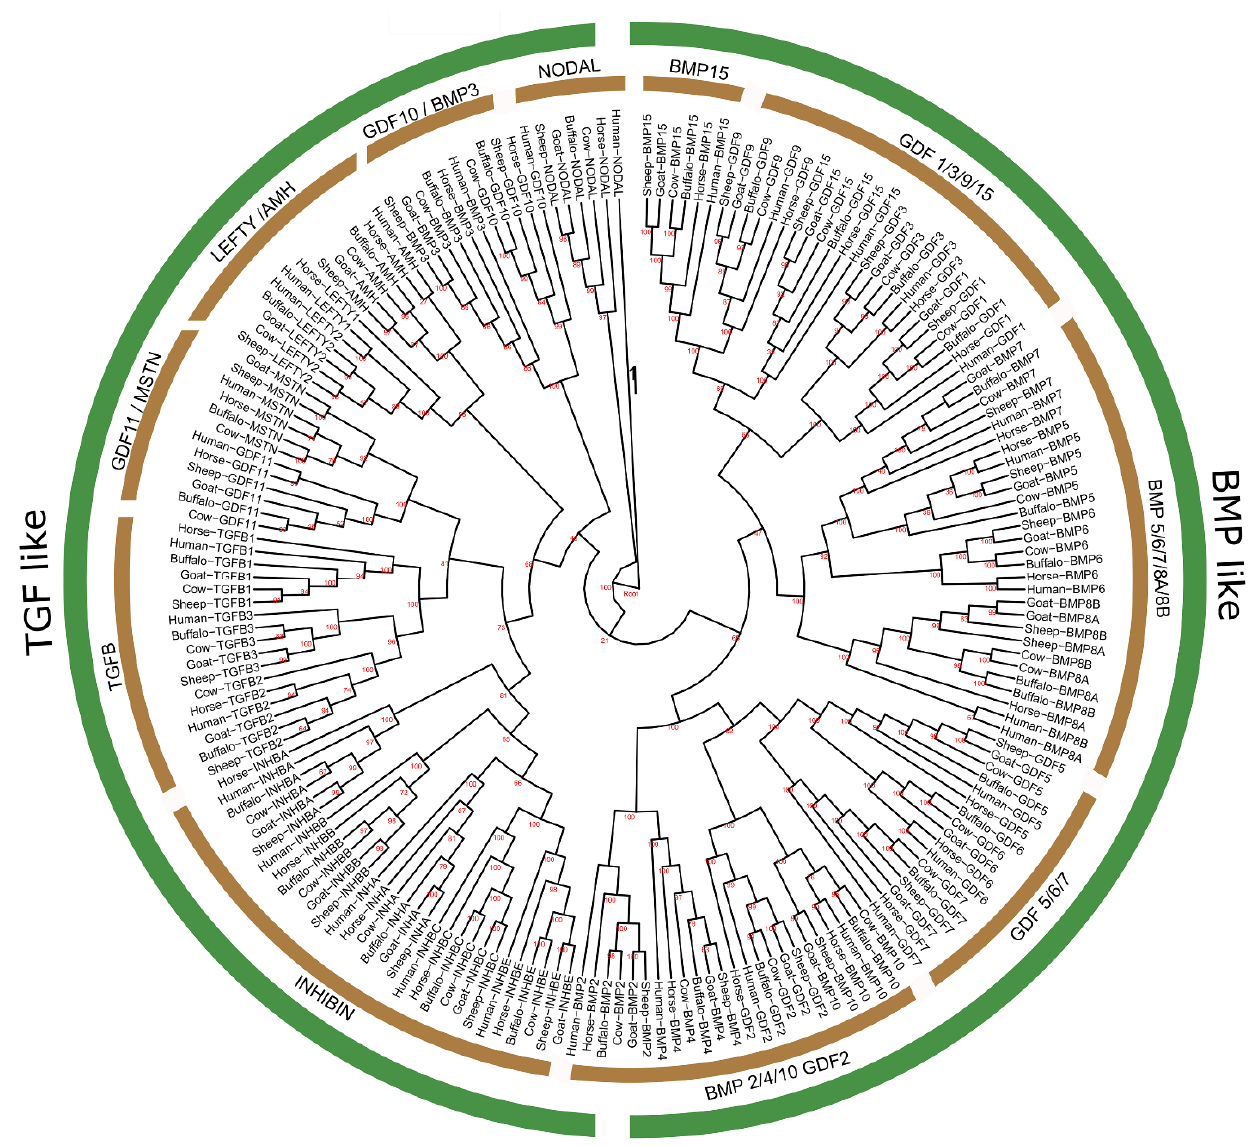
Figure 1. Phylogenetic tree analysis of TGF- β gene family in six representative species.